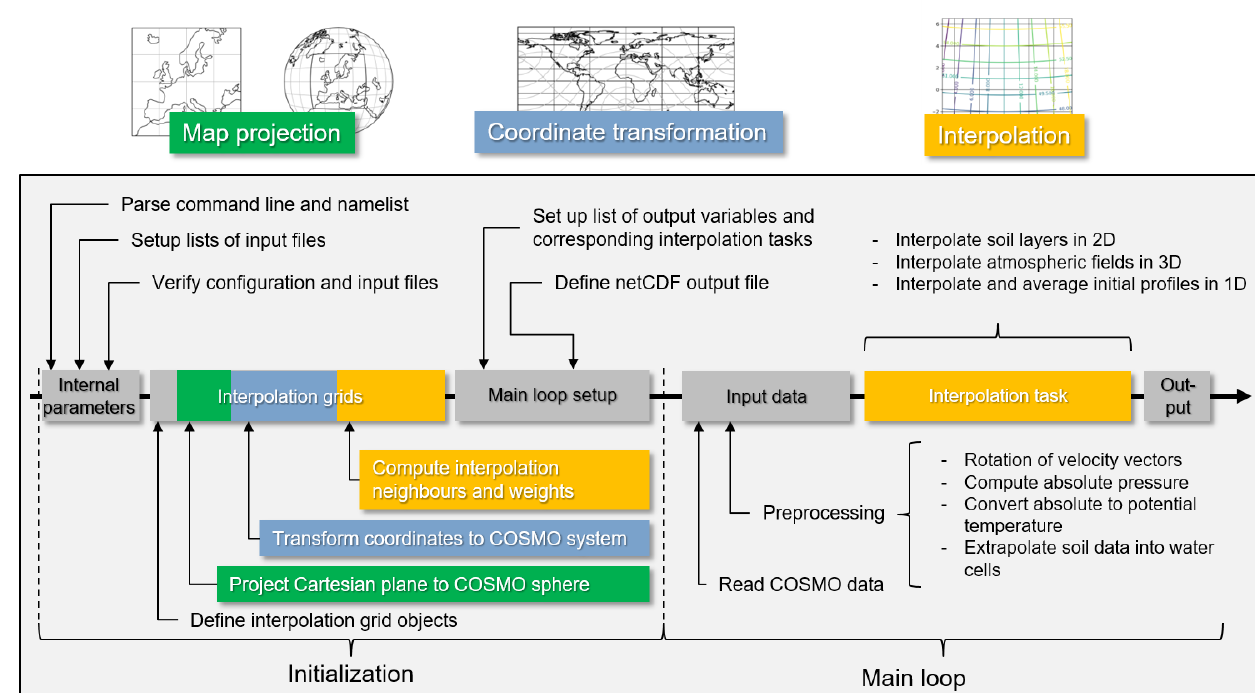
Figure 6. Diagram of INIFOR’s program